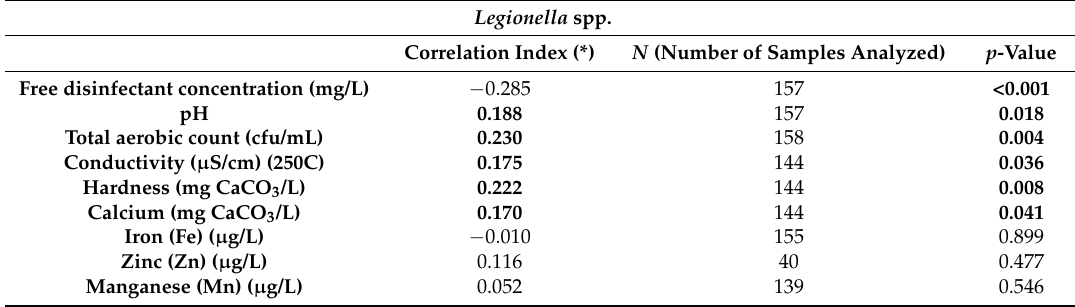
Table 3. Correlation of water physicochemical parameters and colonization of the system with Legionella spp. CFU: colony-forming unit.